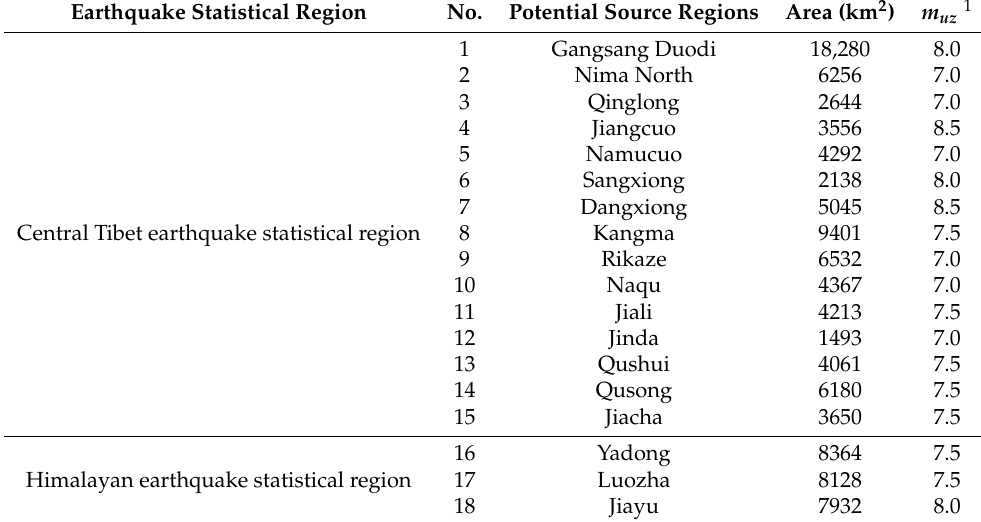
Himalayan earthquake statistical